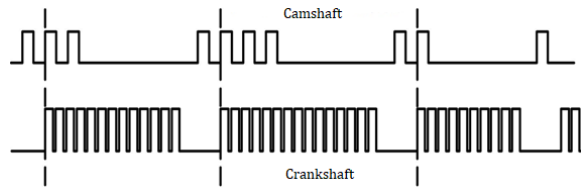
Figure 4. Signals of the crankshaft position sensor and camshaft position sensor on Nissan QG15 A cardinal difference, visible in Fig. 3 as compared